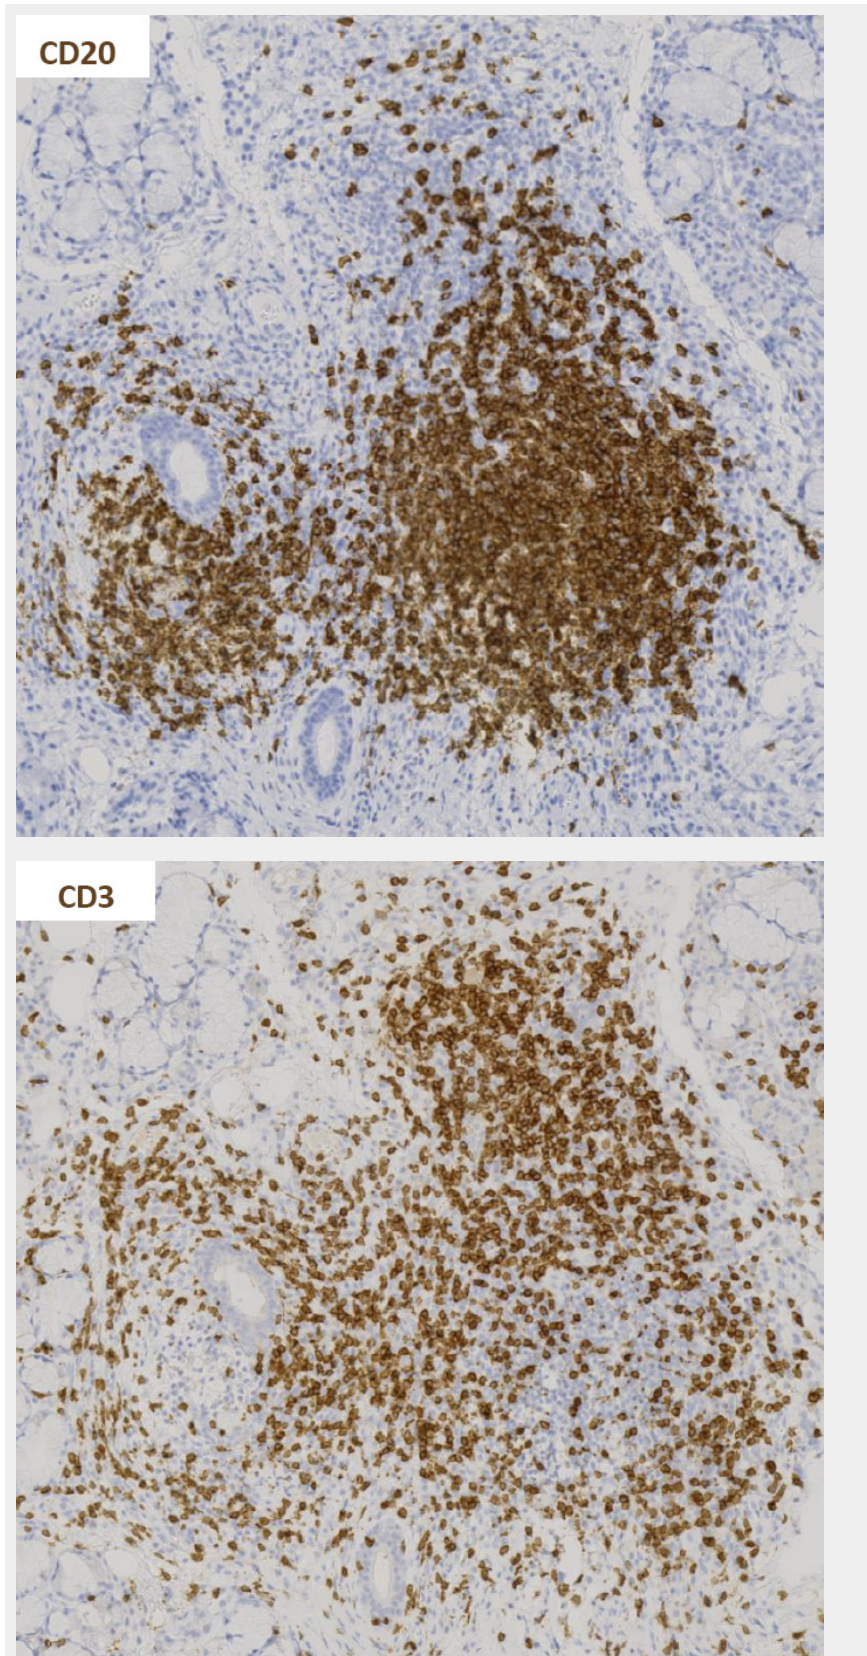
Figure 3 Immunohistochemistry staining for CD20 and CD3 in sequential sections of a labial salivary gland sample showing a large, segregated focus with a predominant B cell